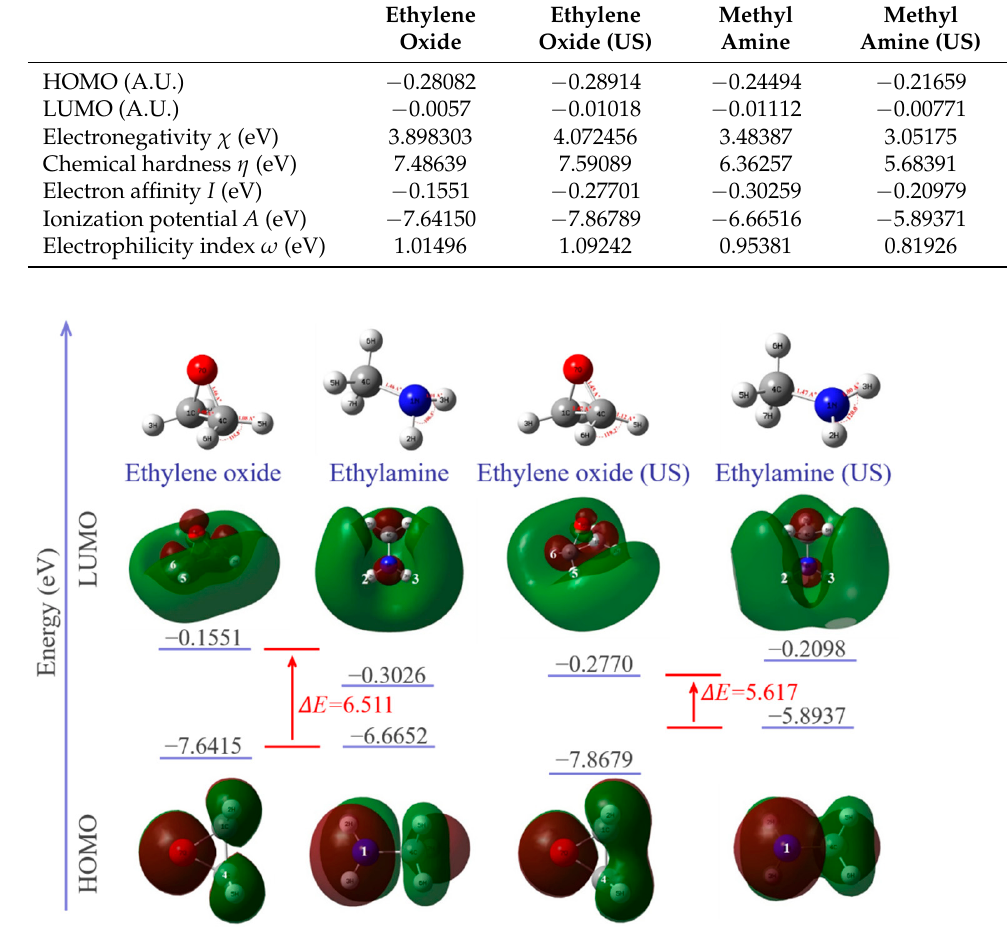
Figure 10. Optimized geometry of each molecule and HOMO/LUMO orbitals with energy levels.